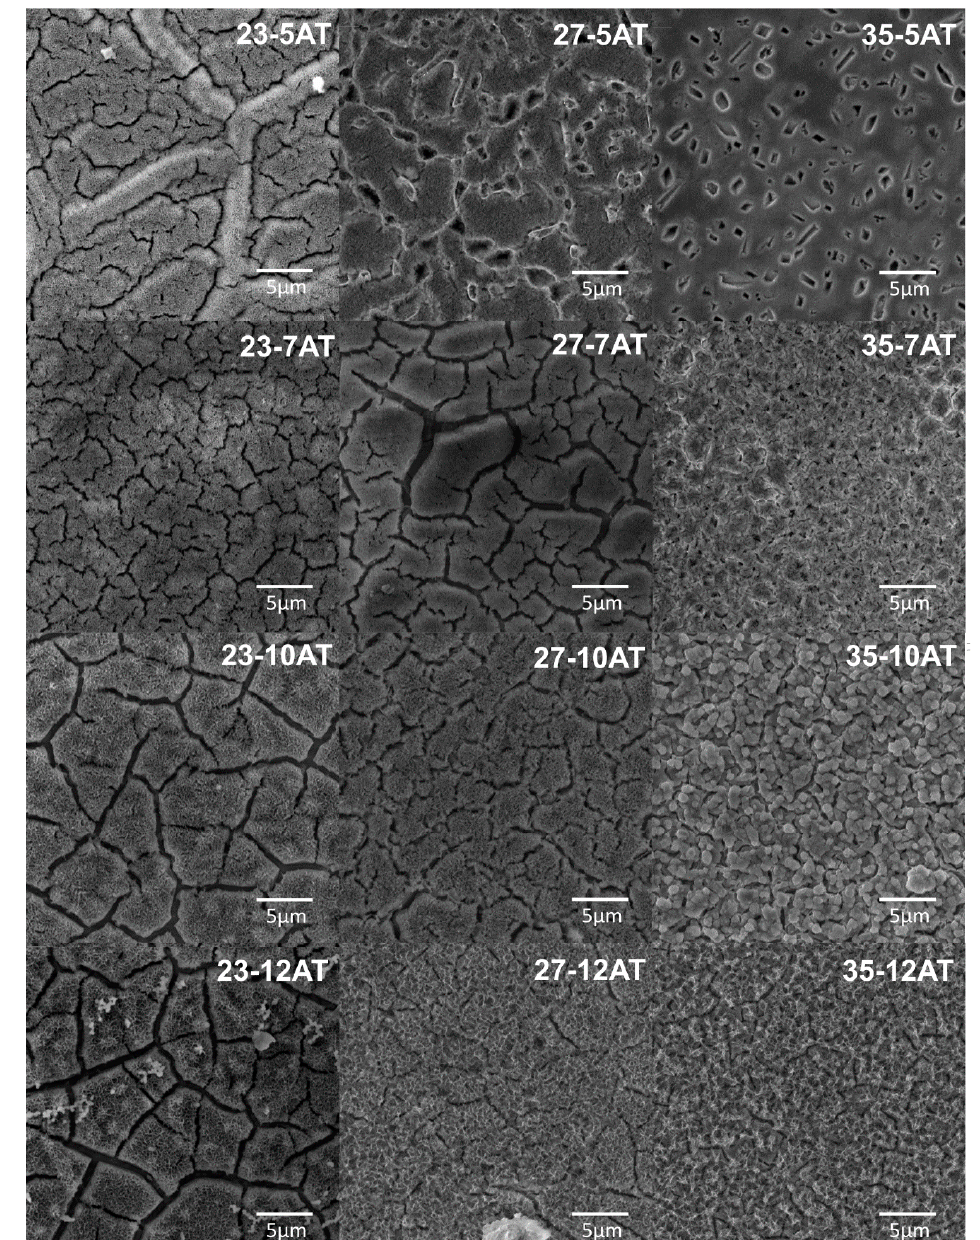
Figure 9. SEM microphotographs of Ti23Mo, Ti27Mo, Ti35Mo, after acid etching and alkaline treatment in various molar concentrations of NaOH.